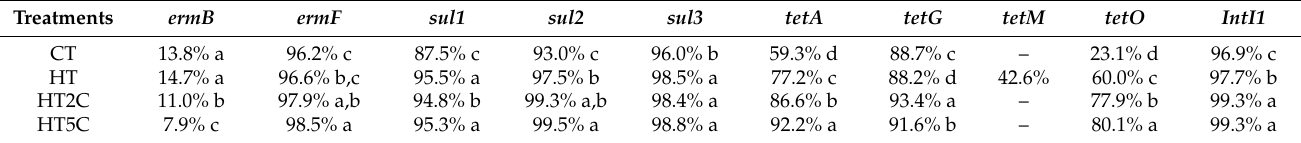
The different lowercase in the table indicated significant differences between treatments at p < 0.05 level.